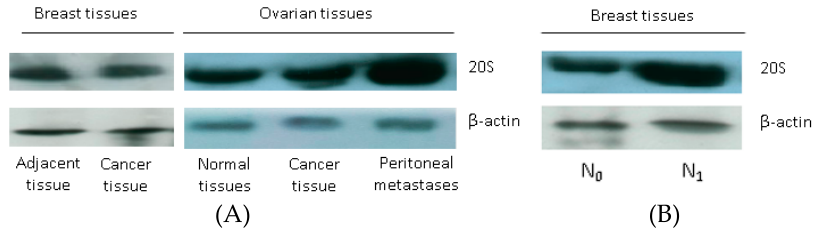
Figure 3. The 20S proteasome level in tissues, detected by Western blot. Western blotting was performed using antibodies against α & β subunits of 20S proteasome. β -Actin was used as the internal control. ( A ) Primary cancer tissues, adjacent breast tissue and normal ovarian and peritoneal metastasis tissues; ( B ) Luminal B subtype breast cancer tissue without (N 0 ) and with regional lymph node metastasis (N 1